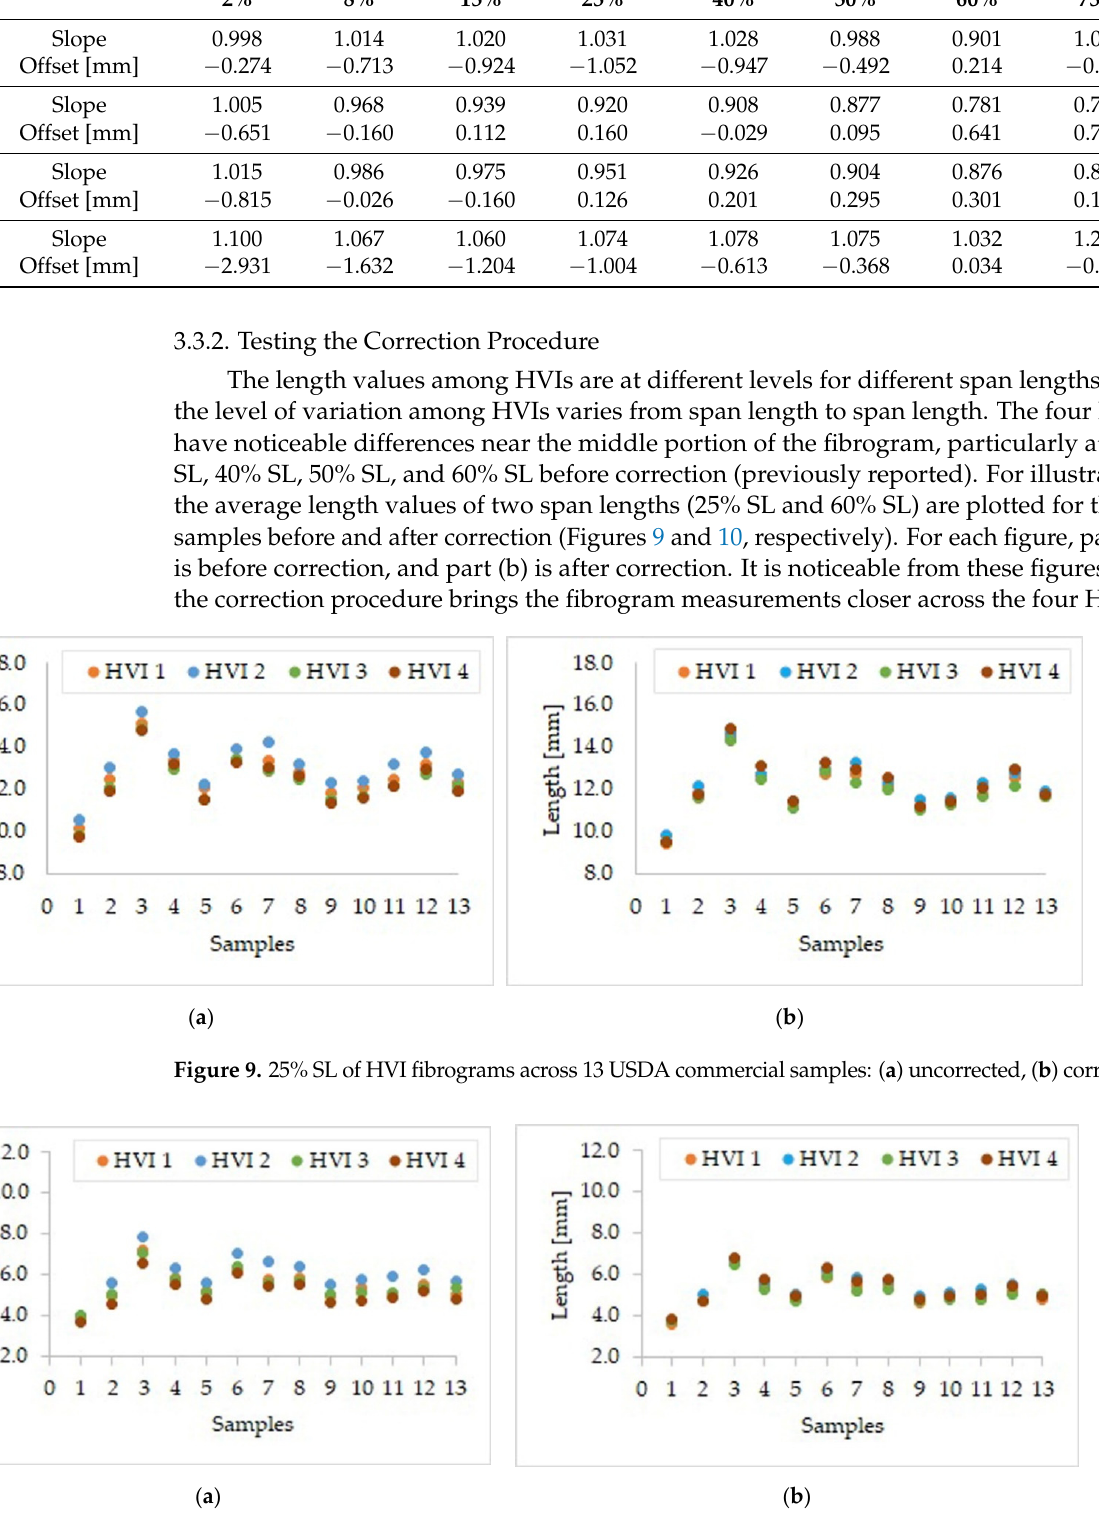
Figure 10. 60% SL of HVI fibrograms across 13 USDA commercial samples: ( a ) uncorrected, ( b ) cor- rected.